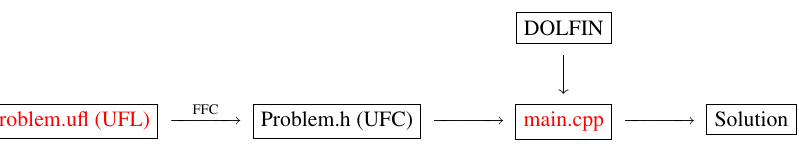
Fig. 2. The FEniCS pipeline viewed from the C++ interface. In the Python interface, the components UFL, FFC, UFC and DOLFIN are more closely integrated.